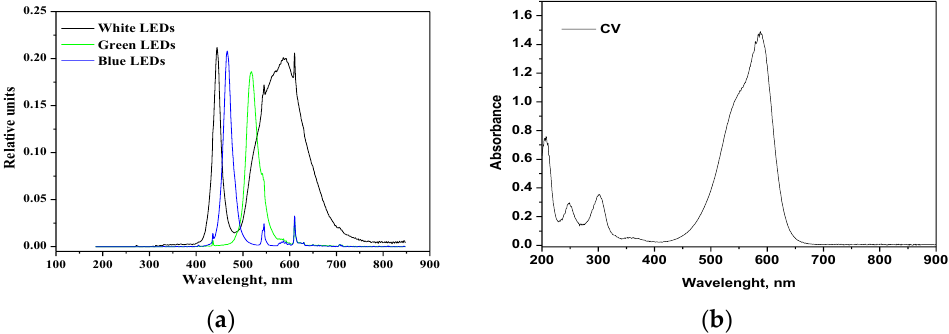
Figure 11. ( a ) Emission spectra of white, green and blue LEDs; ( b ) absorption spectrum of CV aqueous solution.